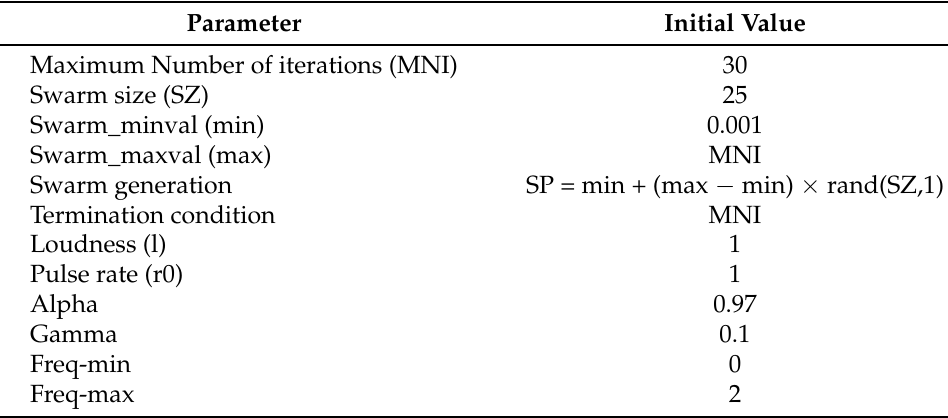
Figure 6. Flowchart of scaling factor ( Γ ) optimization using G-BAT. Table 1. List of basic parameters for hybrid